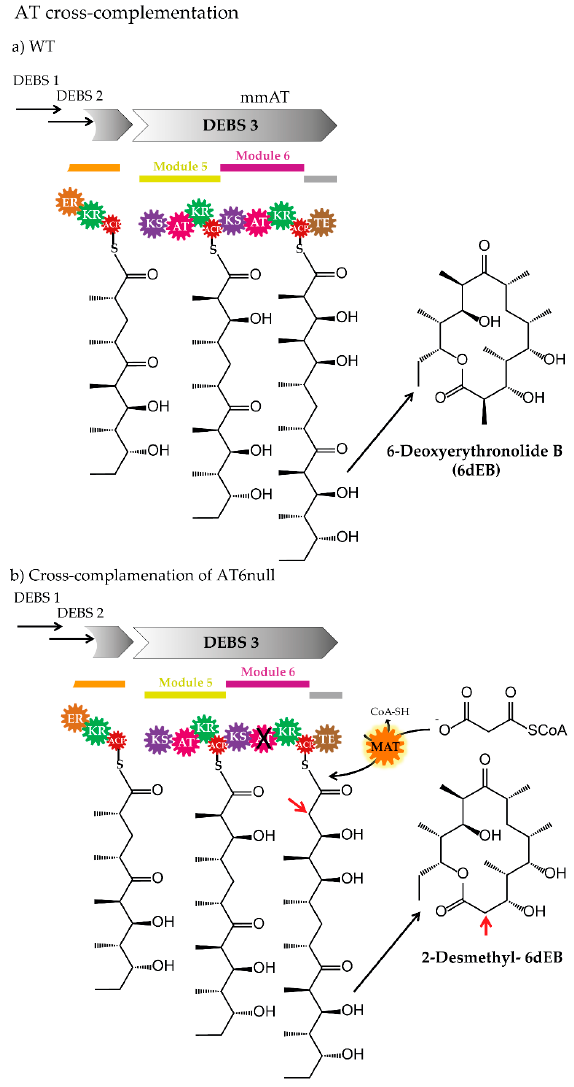
Figure 6. Example of AT cross-complementation [66]. ( a ) Part of the erythromycin biosynthetic pathway illustrating the DEBS complex and the chain intermediates on modules 4, 5 and 6, and the product 6-deoxyerythronolide B (6dEB). ( b ) Part of the erythromycin biosynthetic pathway illustrating the DEBS complex in which the AT6 was inactivated (AT6null) and complemented by a discrete enzyme malonyl-CoA:ACP transacylase (MAT) from Streptomyces coelicolor . The strain produced 2-desmethyl-6dEB. Abbreviations: AT, acyltransferase; ACP, acyl carrier protein; KS, ketosynthase; KR, ketoreductase; TE, thioesterase; mmAT: AT loading